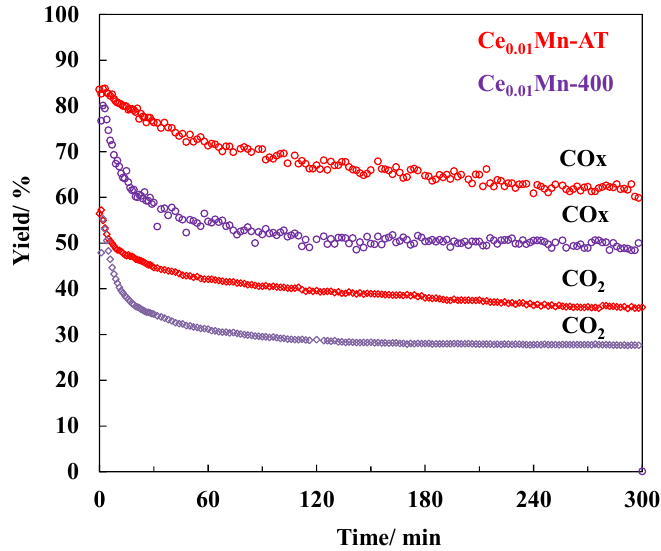
Figure 8. CO x and CO 2 yields obtained for TCE abatement (RH = 0.7%) in the PPC configuration with Ce 00.1 Mn-400 and Ce 0.01 Mn-AT as catalysts.